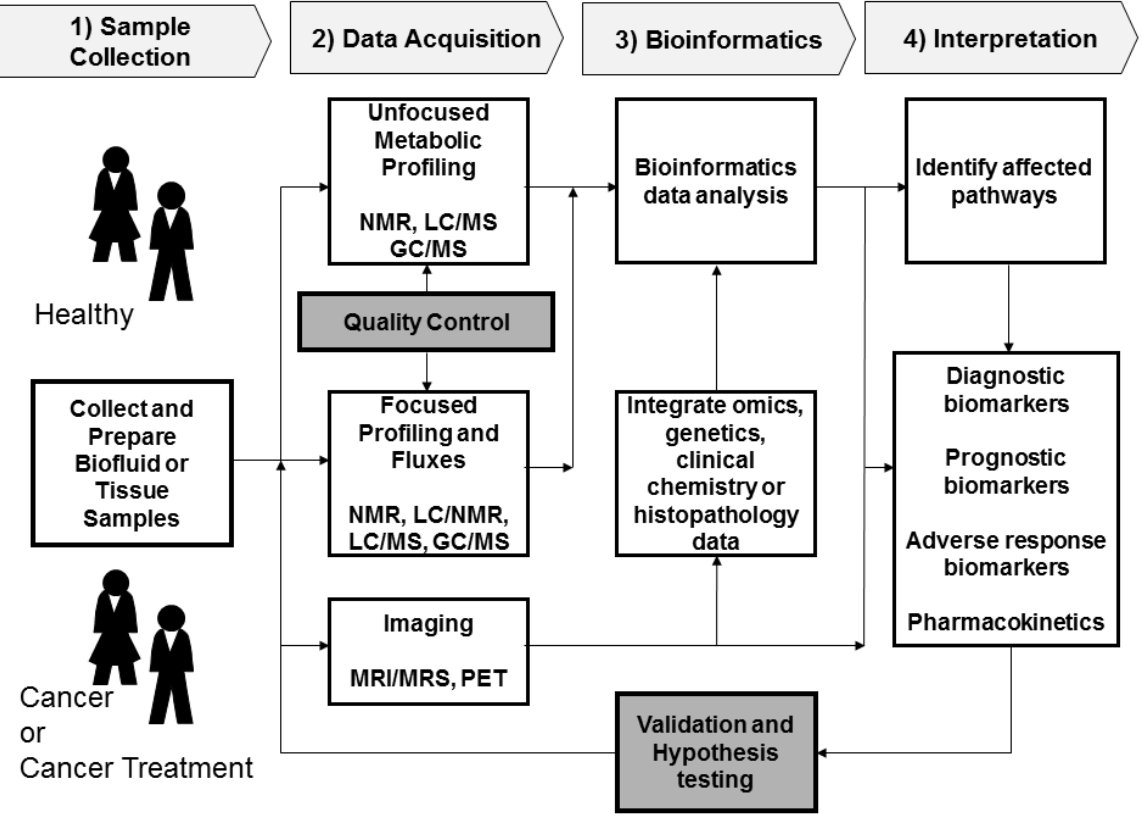
Figure 1. General flow chart of a typical metabolomics experiment in a cancer